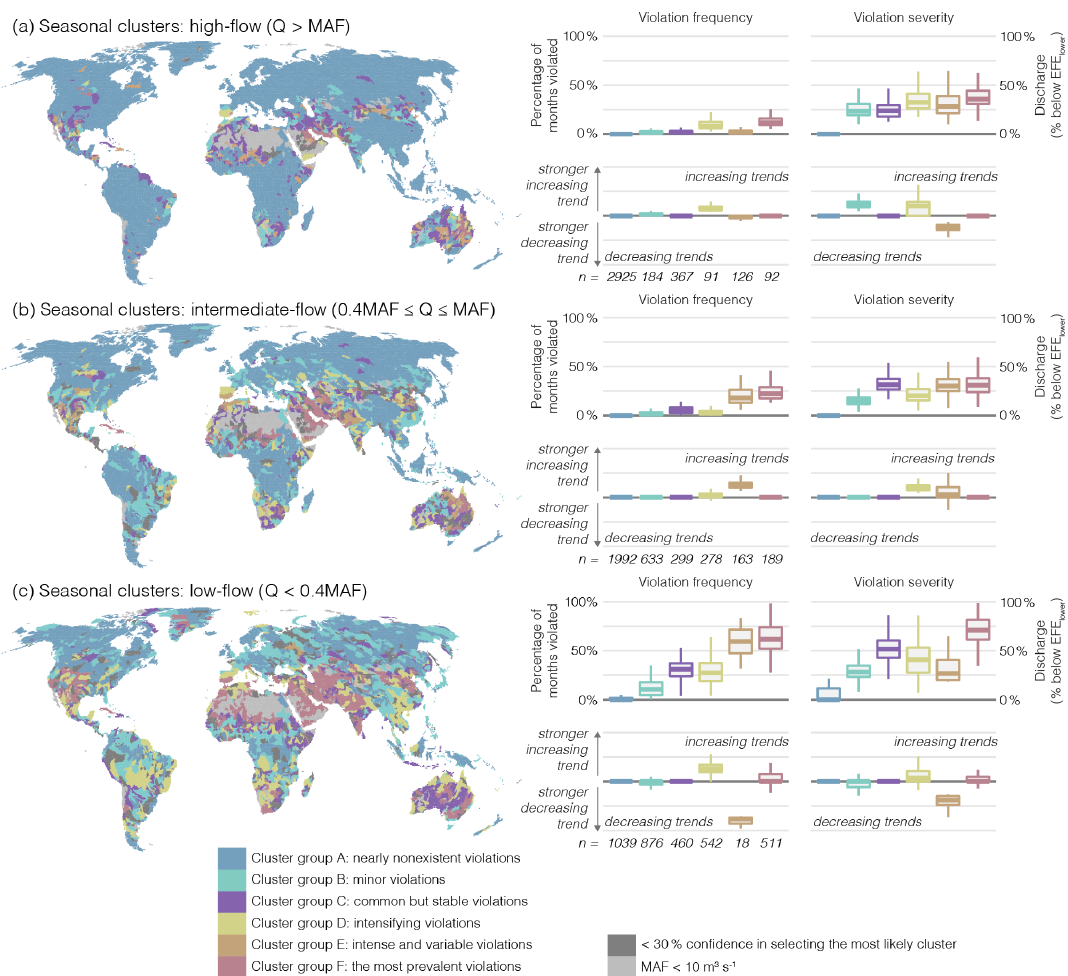
Figure 5. Seasonal clustering of sub-basins based on environmental flow envelope (EFE) lower bound violations during high-flow season (a) , intermediate-flow season (b) , and low-flow season (c) . Q stands for monthly discharge and MAF for mean annual flow. The four clustering variables constitute violation frequency, violation severity, and linear trend slopes associated with both variables. In the trend slope box plots, the position of each box is proportional to the linear trend slope; boxes further away from the middle line indicate steeper trend slopes and therefore more rapid change in violation metrics. Sub-basins with MAF less than 10m 3 s − 1 at the sub-basin outlet were excluded from the